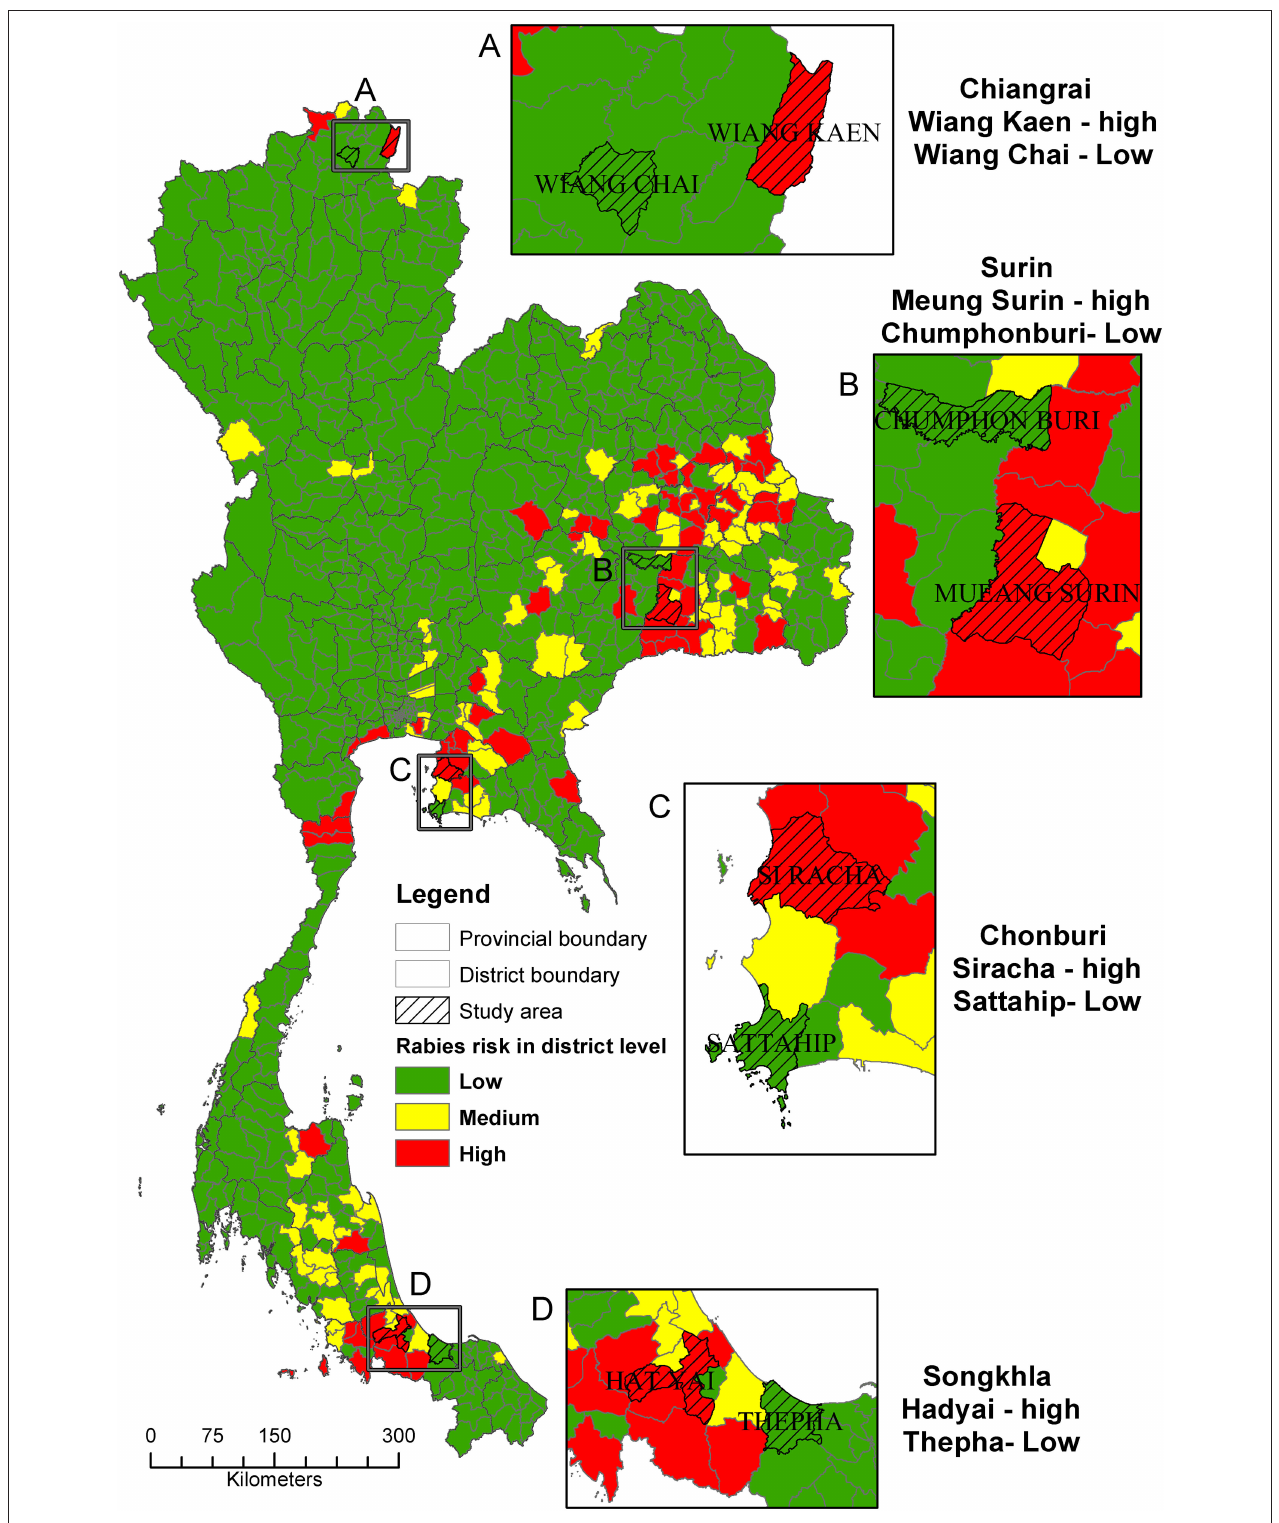
FIGURE 1 | A map depicting the risk level of canine rabies transmission at district level for the selection of study areas (shaded; A–D ) in the four main regions of Thailand.